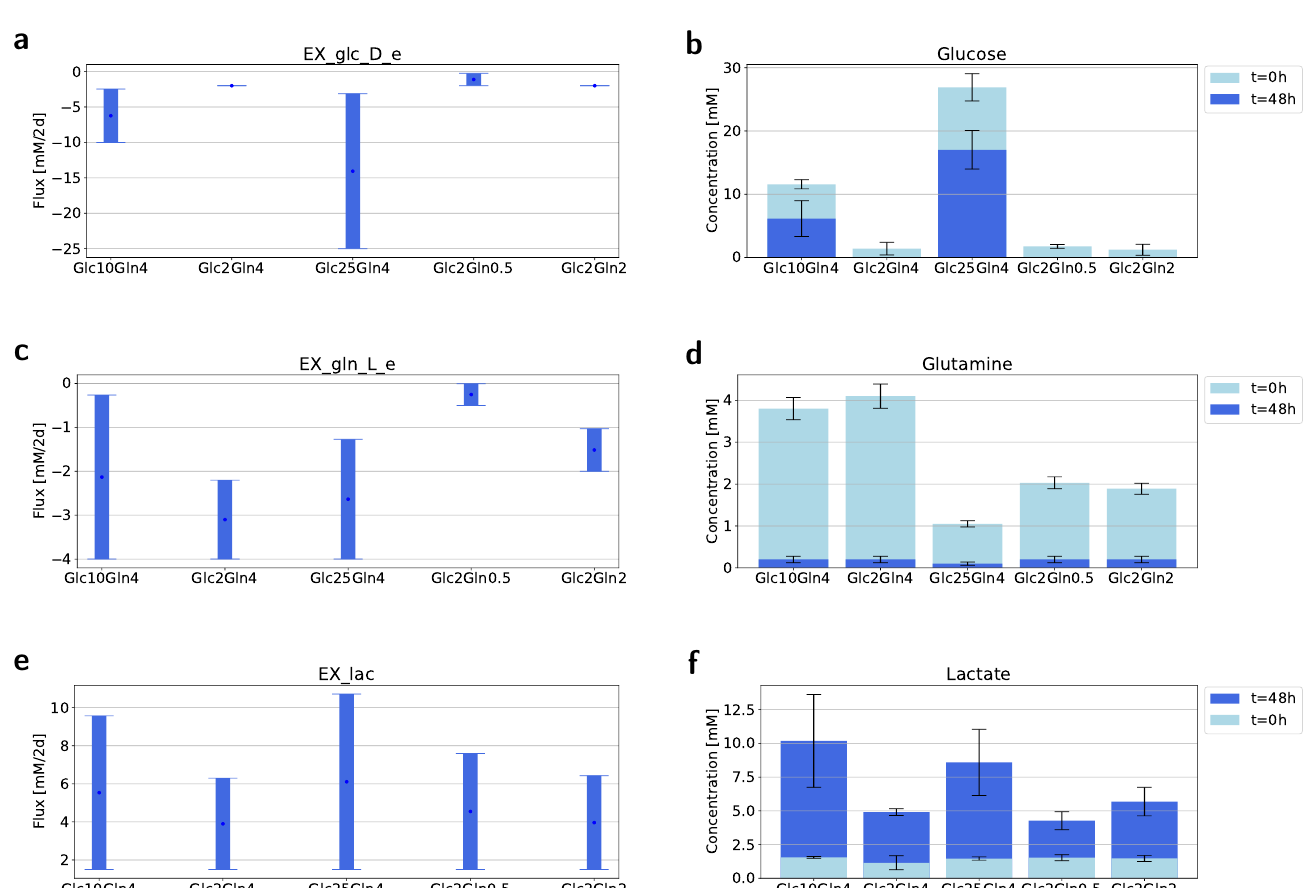
Figure 4. Predicted and observed ranges of the uptake/secretion of glucose, glutamine and lactate. ( a , c , e ) The range of fluxes of glucose ( a ), glutamine ( c ) and lactate exchange reaction ( e ) consistent with the maximal biomass flux and steady state across five different media. ( b , d , f ) The concentration of glucose ( b ), glutamine ( d ) and lactate ( f ) in five different media before and after carrying out experiments *. * The concentration of the cells at t = 0 was 200,000